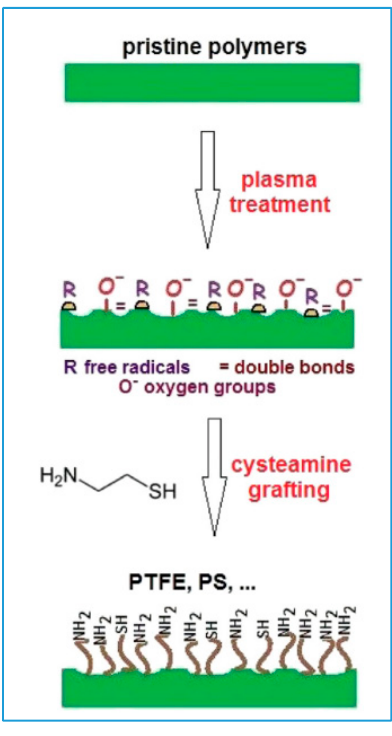
Figure 3. Scheme of grafting of cysteamine on plasma treated PTFE and PS [79].